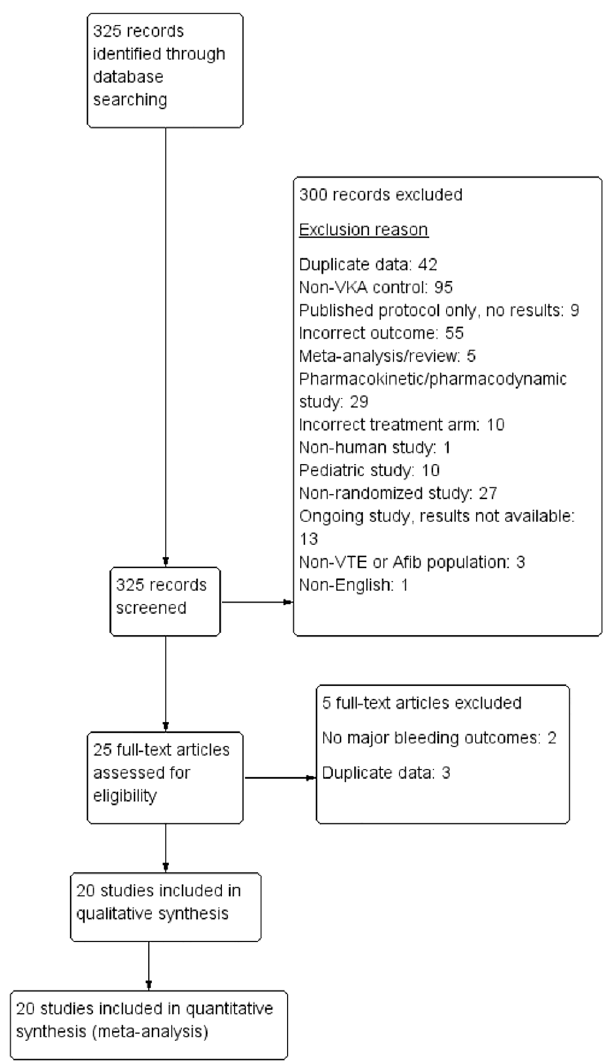
Fig 1. Study selection flowsheet. Flowsheet of the study selection process according to PRISMA guidelines.